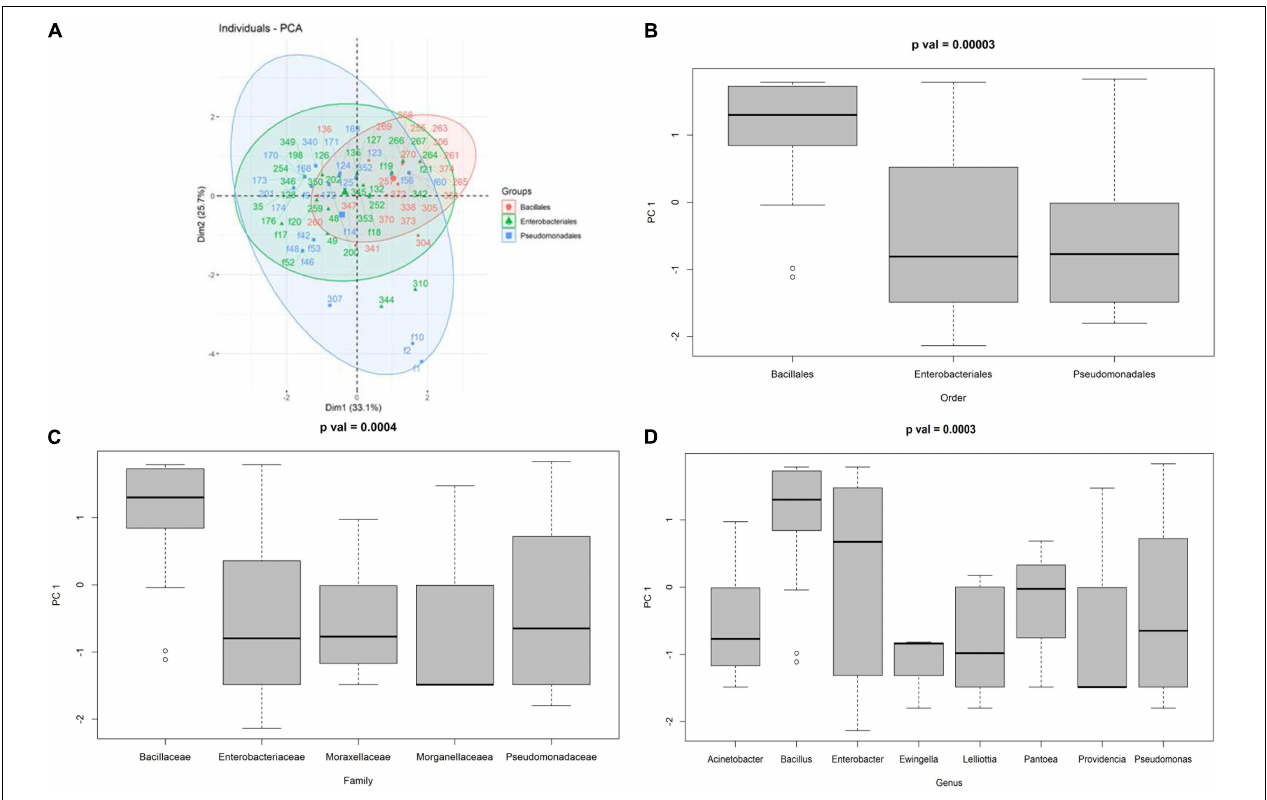
FIGURE 7 | (A) PCA of the antagonist activity of the endophytic bacteria against Cmm , Pco , Pto , Xep , and Fol , boxplot of the distribution of the first principal component given the order (B) , family (C) , and genus (D). TABLE 3 | Results of the in vivo assays of the biocontrol activity of bacterial endophytes against the tomato bacterial pathogens Clavibacter michiganensis subsp. michiganensis ( Cmm ) and Xanthomonas euvesicatoria pv. perforans ( Xep ). Cmm Xep Bacterial strains DI 30 dpi a